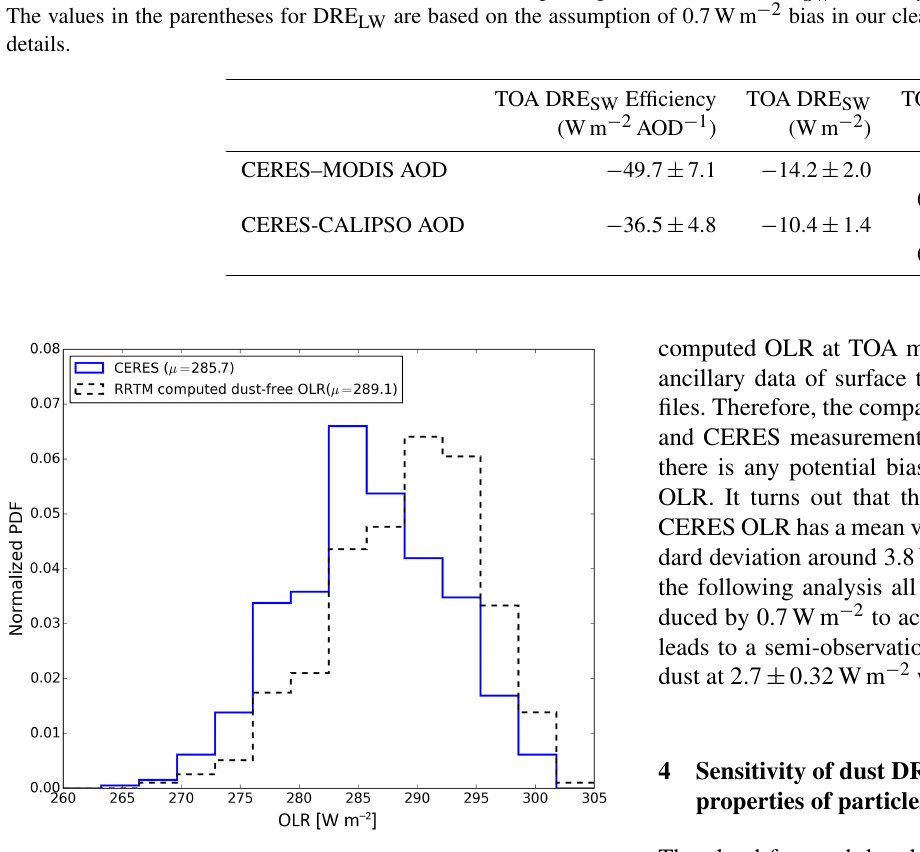
Figure 6. Probability density function (PDF) of observed OLR from CERES (i.e., with dust) and computed dust-free OLR based on the atmospheric profiles and surface temperature reported in